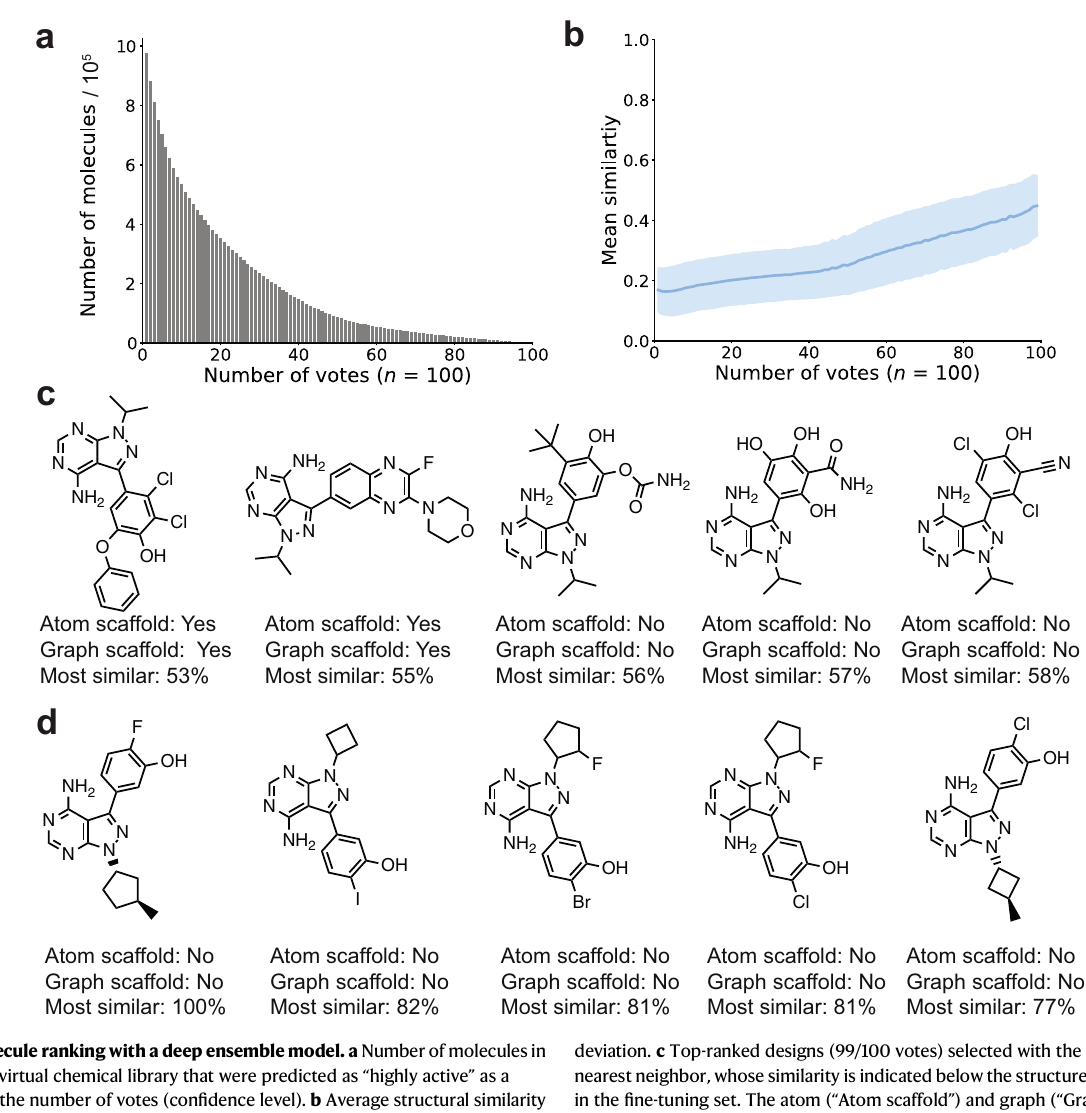
Fig.3|Moleculerankingwithadeepensemblemodel.a Numberofmoleculesin the re fi ned virtual chemical library that were predicted as “ highly active ” as a function of the number of votes (con fi dence level). b Average structural similarity (Tanimoto similarity index computed on Morgan fi ngerprints) of each de novo design to the fi ne-tuning set as a function of the number of votes. The solid line represents the mean value, with the shaded area representing the standard